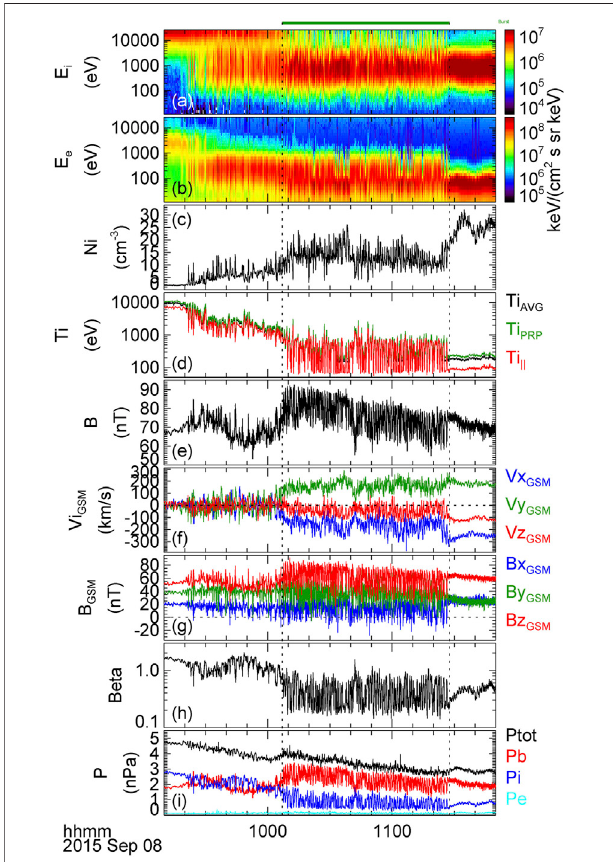
FIGURE 1 | MMS-1 observations in fast survey mode from 0910 UT to 1150 UT on 8 Sept 2015: (A) ion omni-directional energy-time spectrogram; (B) electron omni-directional energy-time spectrogram; (C) ion plasma number density; (D) ion temperature; (E) magnetic fi eld strength; (F) ion velocity in the GSM coordinate system; (G) magnetic fi eld GSM components; (H) plasma β ; (I) magnetic fi eld pressure (red), ion plasma pressure (blue), electron plasma pressure (cyan) and their sum